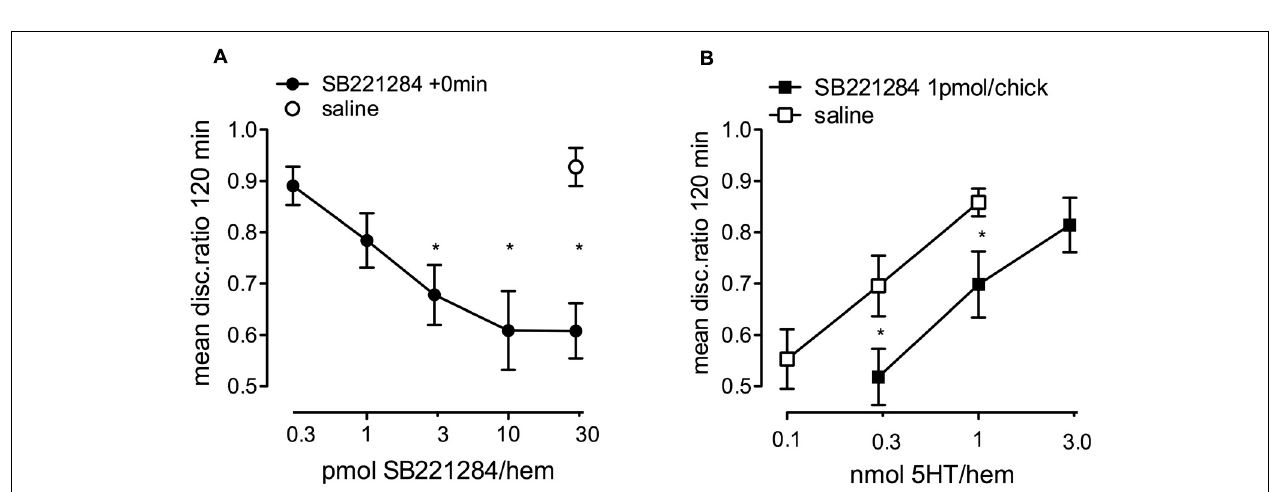
FIGURE 4 | Effect of the serotonin antagonist, methiothepin, on strongly reinforced memory. (A) dose-response relationship for methiothepin injected immediately after training, n = 11–17 per group. (B) Time of injection of 2.5 nmol/hem of methiothepin relative to training and tested 120 min after training, n = 11–19 per group. (C) Memory retention in different groups of chicks tested at selected times after training and injection of methiothepin,